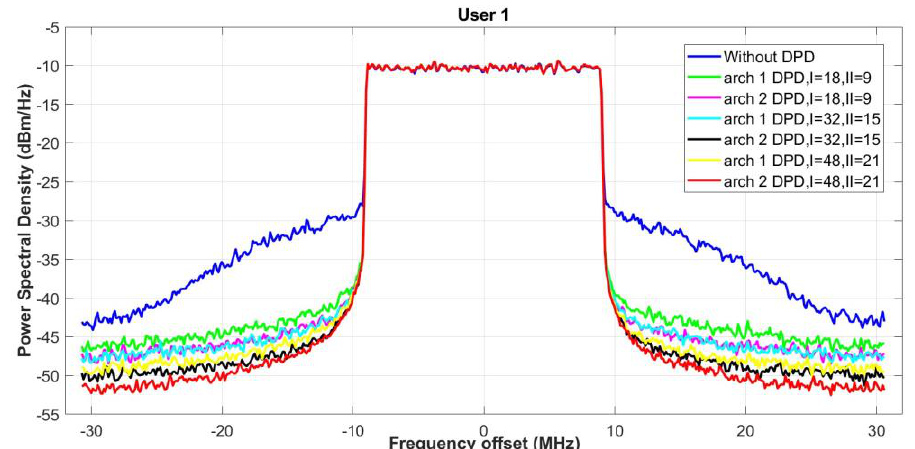
Figure 8. Power Spectral Density of the MU FC HBF mMIMO — user 1.